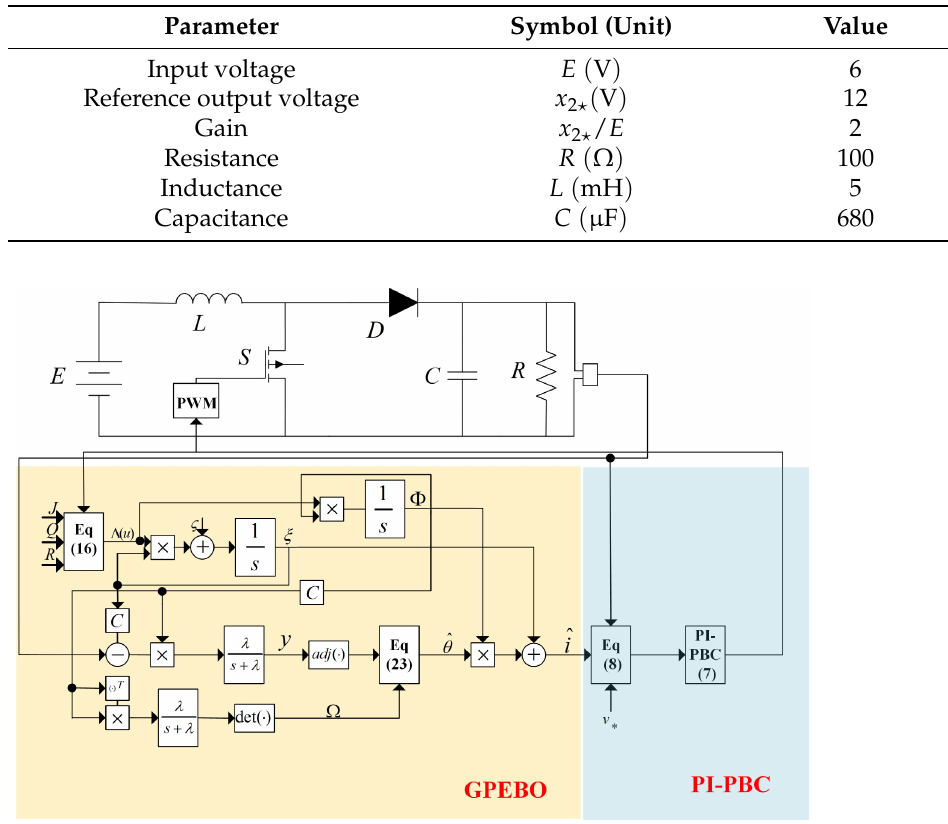
Figure 3. The structure of the proposed sensorless